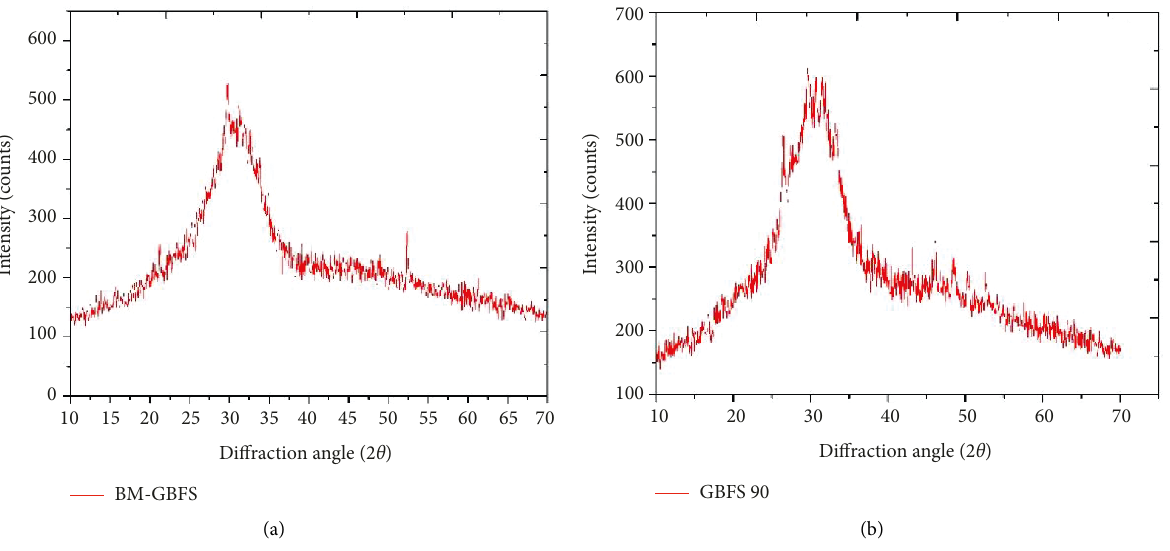
Figure 5: X-ray diffraction of GBFS (a and